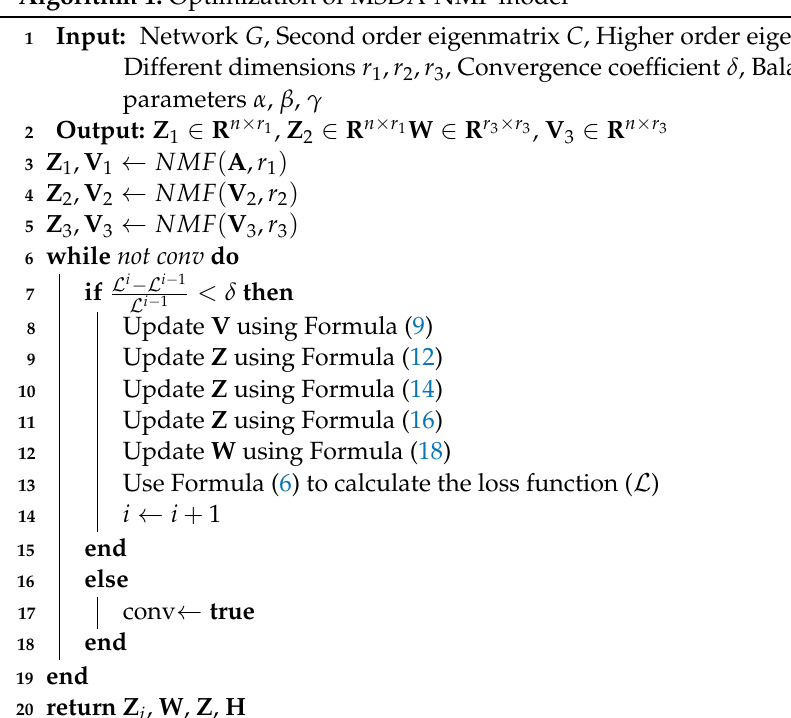
Algorithm 1: Optimization of MSDA-NMF